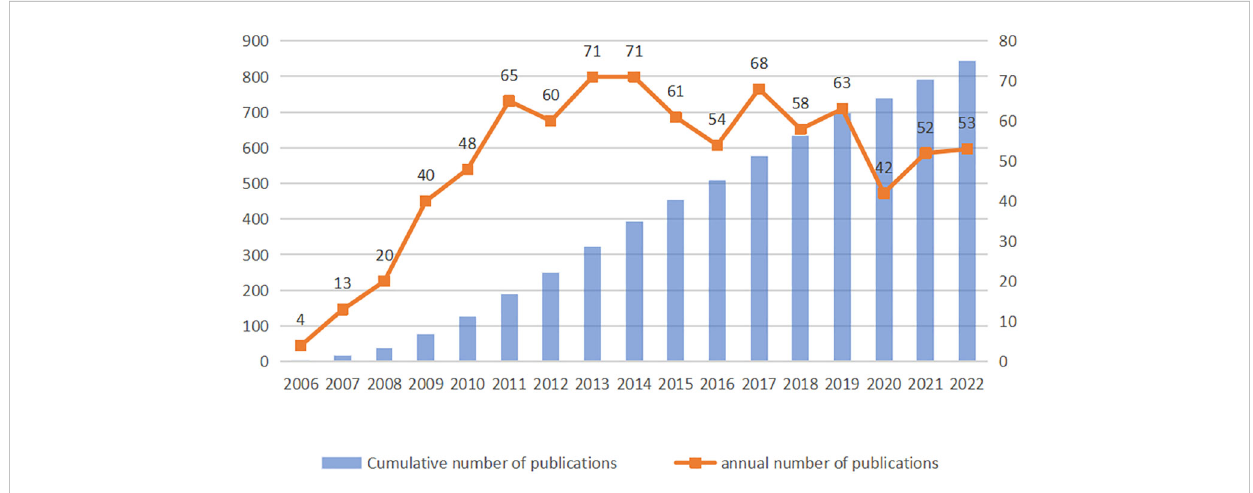
FIGURE 1 Trends in the annual and cumulative number of publications in the fi eld of elite